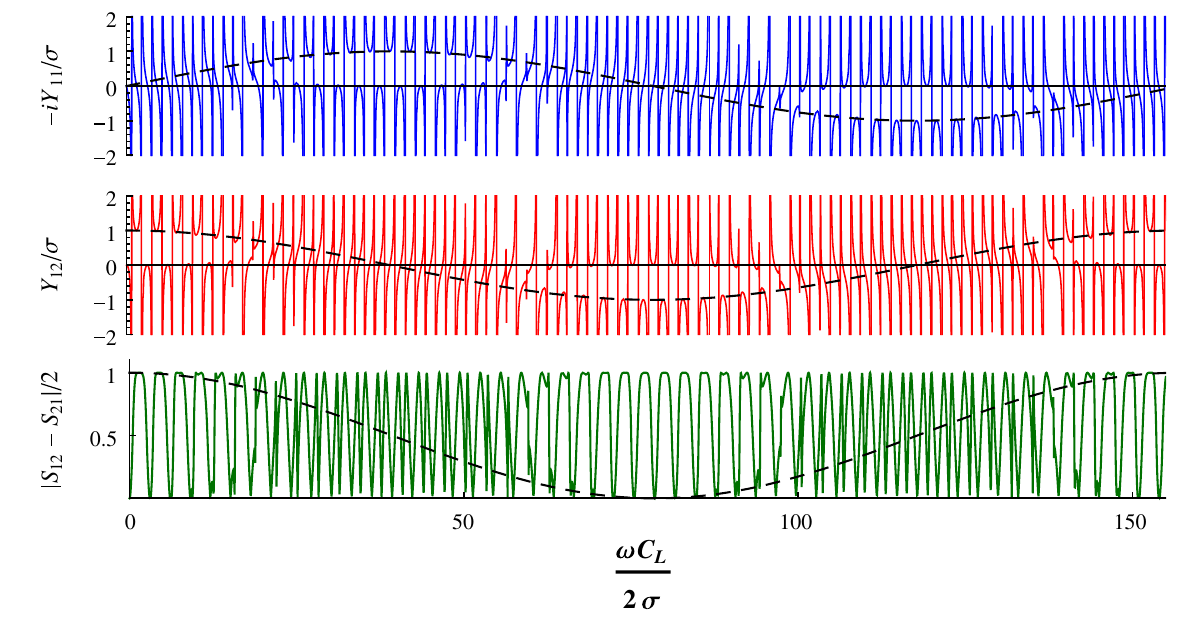
FIG. 9. The behavior of the admittance [Eq. (25)] and of the scattering parameters [cf. Eqs. (3) and (4) with Z 0 ¼ 1 = σ ] for the two-port device with smoothed capacitive contacts. The capacitance function is as given in Eq. (30), with λ ¼ L= 12 . We show a large range of frequency, including about 100 poles of the admittance, and about 50 good gyration points as given by Eq. (28), in order that the slow modulation of ω on the scale σ =c λ can be seen. The dashed lines showing this modulation sinusoid are guides to the eye. Top panel: (11) component (pure imaginary) of the admittance matrix Y 2 . Middle panel: (12) component of the admittance matrix Y 2 P jð S Þ − ð S Þ j = 2 . Because of unitarity, this quantity can attain the value unity only if good gyration is achieved [ S matrix 2 P; λ 2 P; λ 1 ; 2 2 ; 1 proportional to Eq. (2)]. We see that, despite the modulation caused by smoothing, perfect gyration occurs regularly along the frequency axis, at points close to those given by Eq. (28) for the unrounded